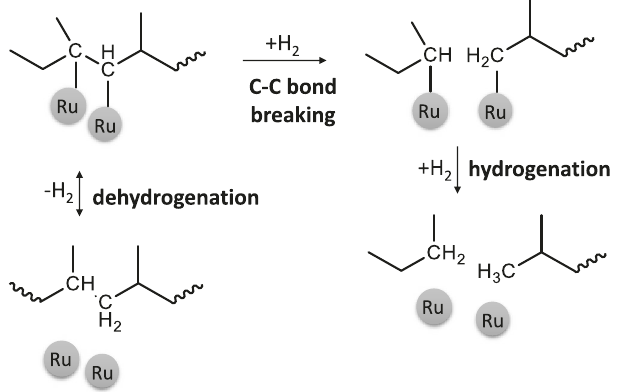
Fig. 5 | Major steps in C – C bond hydrogenolysis of polypropylene. Dehy- drogenation happends in both directions, while C – C bond breaking is considered